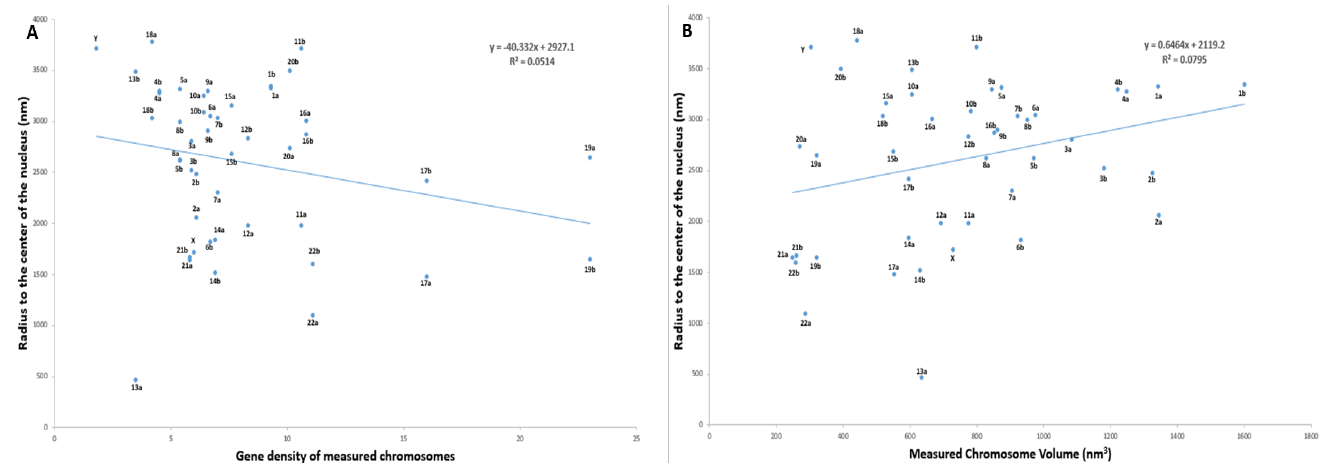
Figure 7. Radial organization of all 46 prophase chromosomes in a 3D nuclei. ( A ) Scatter diagram showing correlation between chromosome volume and radius to the center of the nucleus. ( B ) Scatter diagram showing correlation between chromosome gene density and radius to the center of the nucleus.